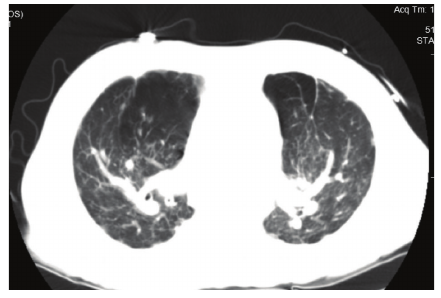
Figure 3: Chest computography with extensive calcification, scar- ring, and areas of